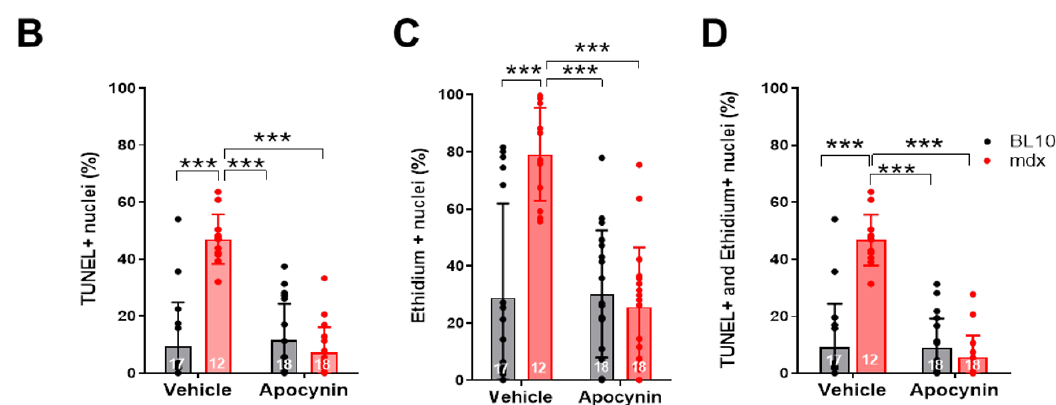
Figure 4. NADPH oxidase inhibition with apocynin reduces apoptosis and permeability in dystrophic hearts. ( A ) Representative fluorescence microscopy images of cardiac sections processed to show total nuclei with DAPI staining (blue), apoptosis with the TUNEL assay (green), hemichannels permeability by ethidium uptake (red) and the merge of TUNEL and ethidium fluorescence. 10-month-old wild type (BL10) and mdx mice that were treated with the vehicle or apocynin (APO) for one month before the perfusion experiment in the isolated hearts were used. The bar indicates 50 µ m. ( B ) Quantitative analysis of the images, expressed as percentage of positive TUNEL cells (TUNEL + ). ( C ) Percentage of ethidium-positive (Et + ) cells and ( D ) percentage of simultaneously TUNEL + and Et + cells. *** p < 0.001 for the comparisons indicated by the brackets, ANOVA followed by Newman–Keuls post-hoc test. The n is indicated in each bar.